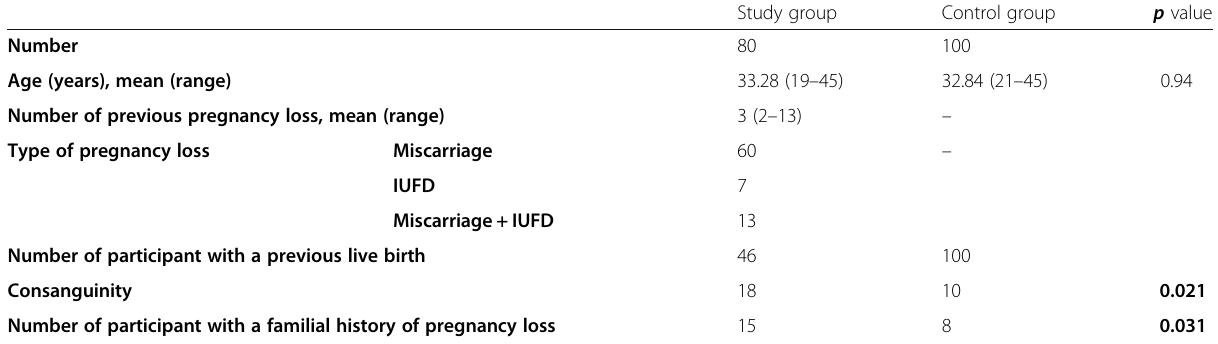
Table 2 Demographic data of patient and control